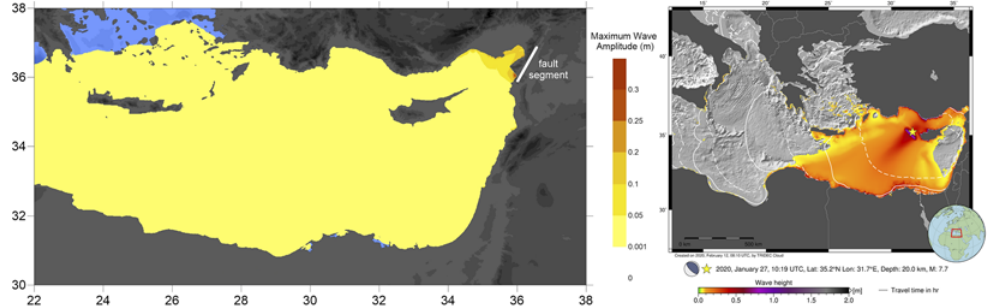
Figure 8. ( left ) Distribution of maximum water surface elevation due to 3 h simulation of the submarine landslide generated tsunami triggered by a Mw 7.4 scenario earthquake (corresponding fault line is shown as a white bar) in NEAMWave17 [27]. ( right ) Initial tsunami conditions, distribution of maximum wave height and wave travel times for the KOERI–NOA NEAMWave21 scenario [28].